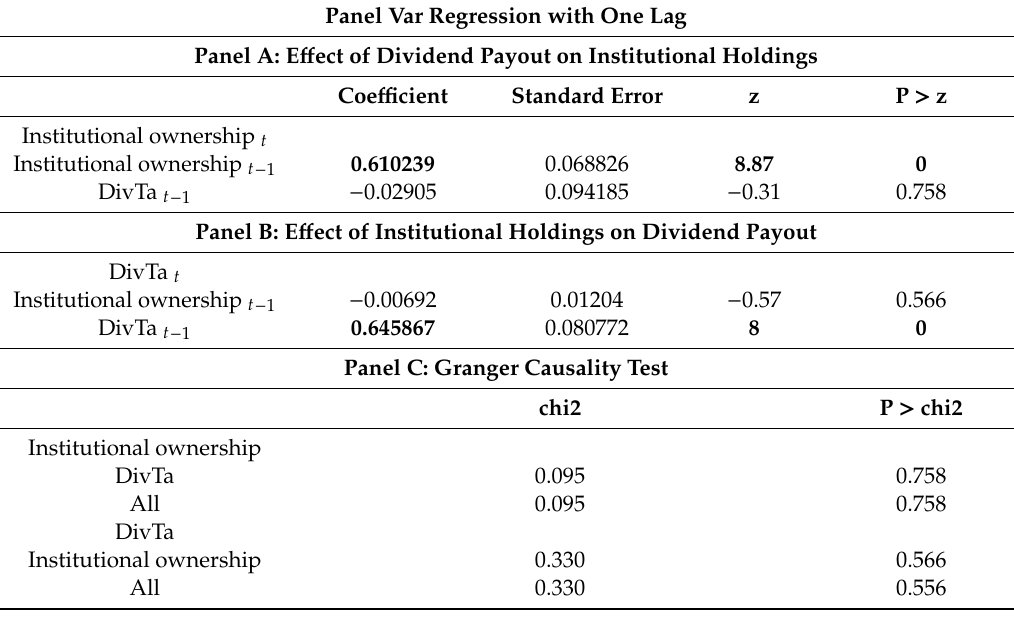
Table 5. Panel Vector Autoregressive Regression. This table reports the results of the panel vector-autoregressive regressions. In the regressions, DivTa is the ratio of dividend to total assets. The variable institutional ownership is the sum of the percentage holdings of the top 20 institutional investors. Industry-fixed and year-fixed e ff ects are included. The standard errors are clustered at the firm level. The sample consists of 3947 firm-year observations for Australian listed firms that paid dividends from 2001 until 2015. The estimates in Panels A and B present the coe ffi cients on the variables and panel C reports the result from the Granger causality test. Panel Var Regression with One